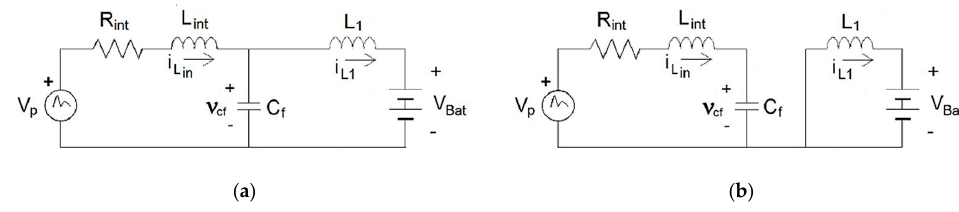
Figure 13. Buck mode, HBB converter topologies: ( a ) ON, ( b ) OFF.